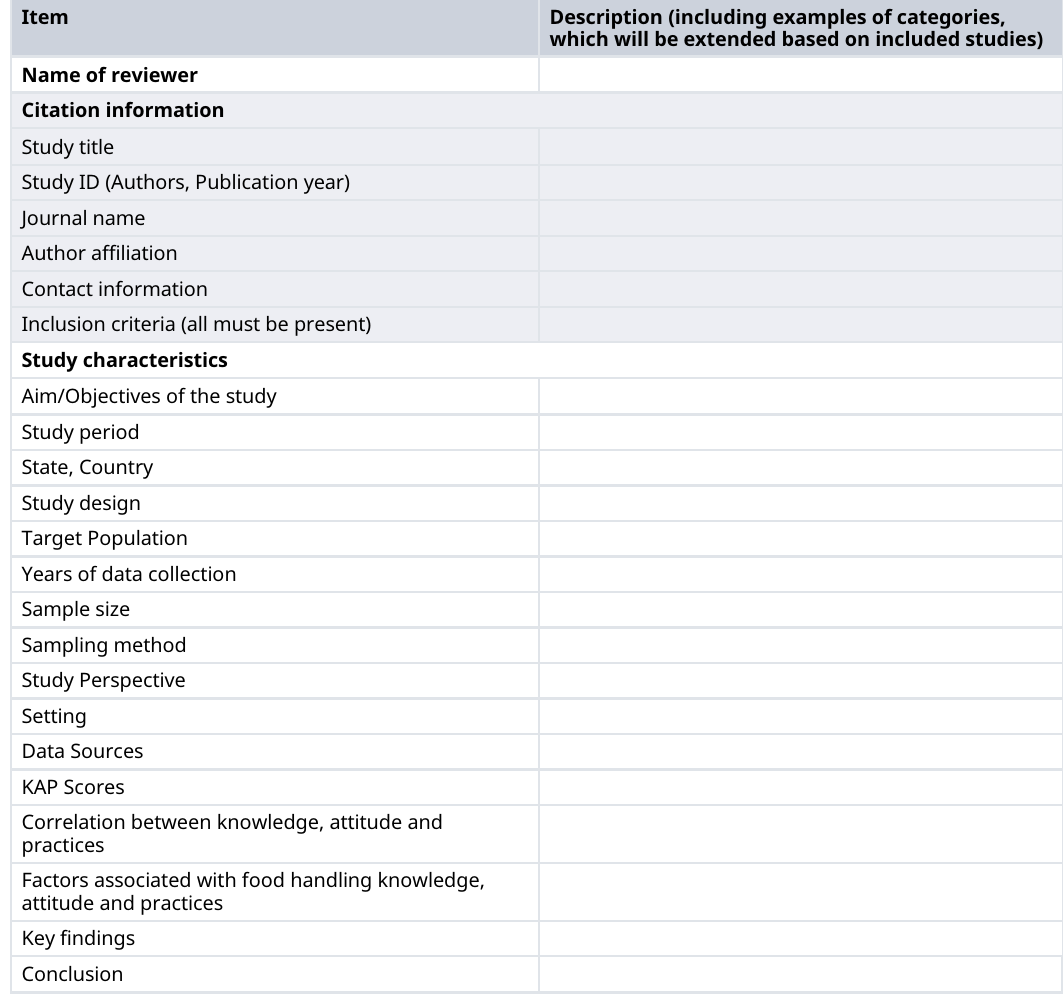
Figshare. PRISMA-P checklist. DOI: https://doi.org/10.6084/m9.figshare.20055176.v1